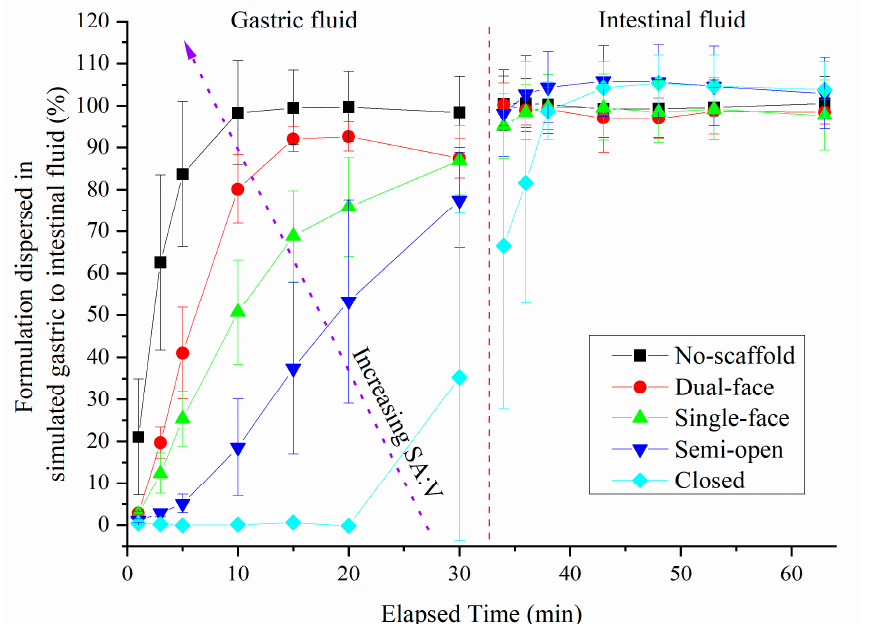
Figure 8. Turbidity of dispersion media resulting from dispersion of fenofibrate-loaded SMEDDS from different single-compartment PLA-based scaffolds (error bars—AVG ± SD, whereby n = 7 for no-scaffold, n = 4 for dual-face, semi-open and single-face, and n = 3 for closed type tablets). The dashed red line indicates the transition from gastric to intestinal conditions. The 100% level was determined by full dispersion of a blank SMEDDS. Pellet without any polymer scaffold.